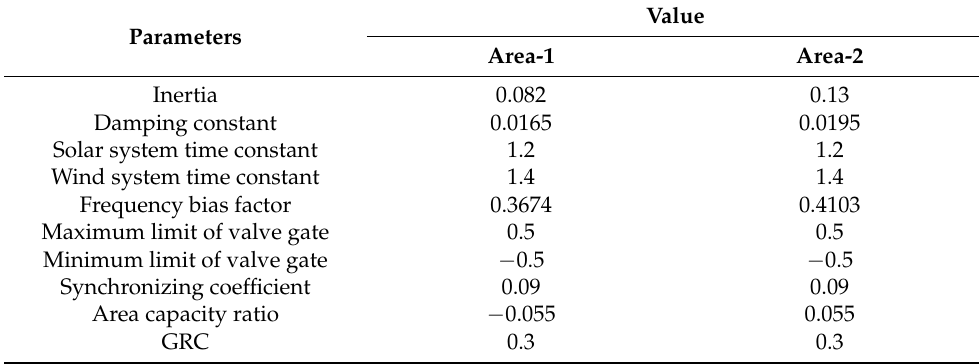
Table 1. System Parameters.